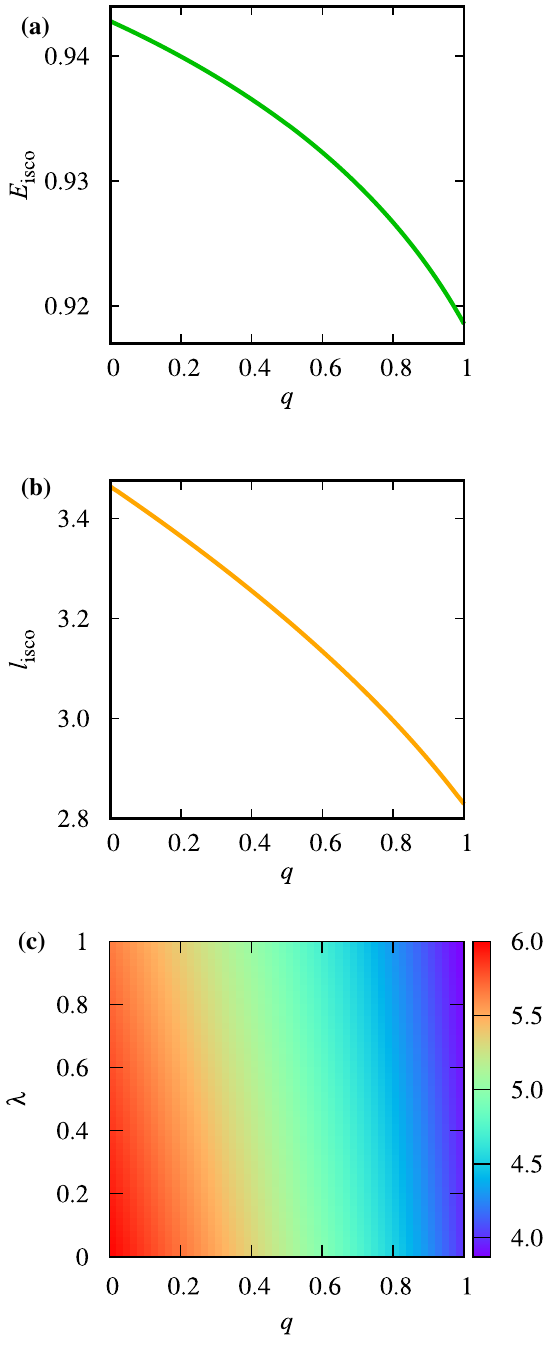
Fig. 2 The energy E isco , the dimensionless angular momentum l isco and the dimensionless radius x isco of the innermost stable circular orbit for the black-bounce-Reissner–Nordström spacetime are shown on the domain D H where E isco and l isco are independent on λ